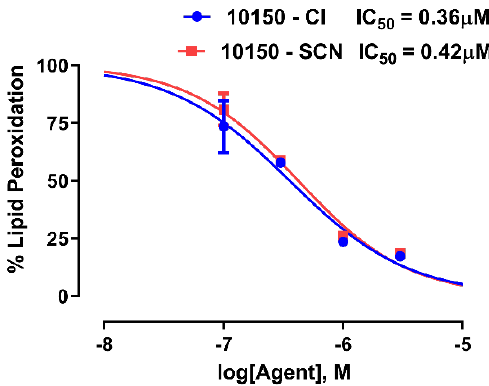
Figure 6. Comparison of the lipid peroxidation inhibition activity levels of chloride ( − Cl) and thiocyanate ( − SCN) formulations of AEOL10150 . The lipid peroxidation of rat brain homogenates was initiated by iron/ascorbate and the lipid peroxides were measured by a thiobarbituric acid reactive species (TBAR) assay. The 50% inhibitory concentrations (IC 50 ) were determined by non-linear regression.